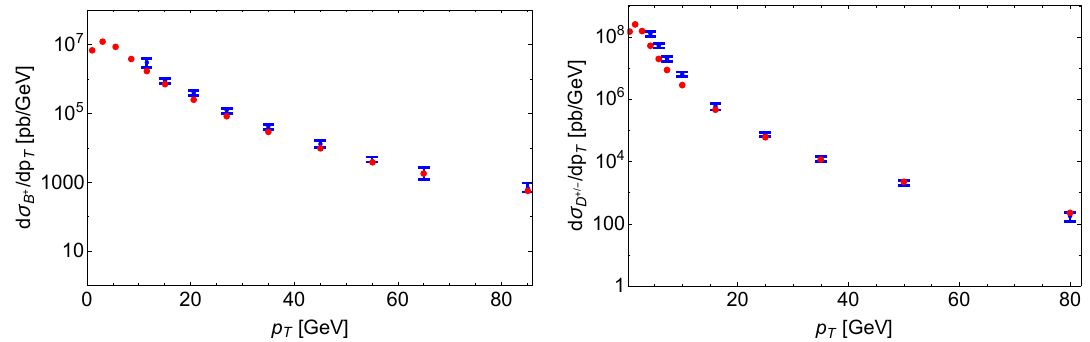
Figure 4 . Comparison of the p T spectra of B + ; D + mesons predicted by the FONLL simulations (red points) with the measurements of the ATLAS and CMS collaborations [65, 66] (blue points with uncertainties bars). Only the central values of the FONLL predictions are shown. See text for